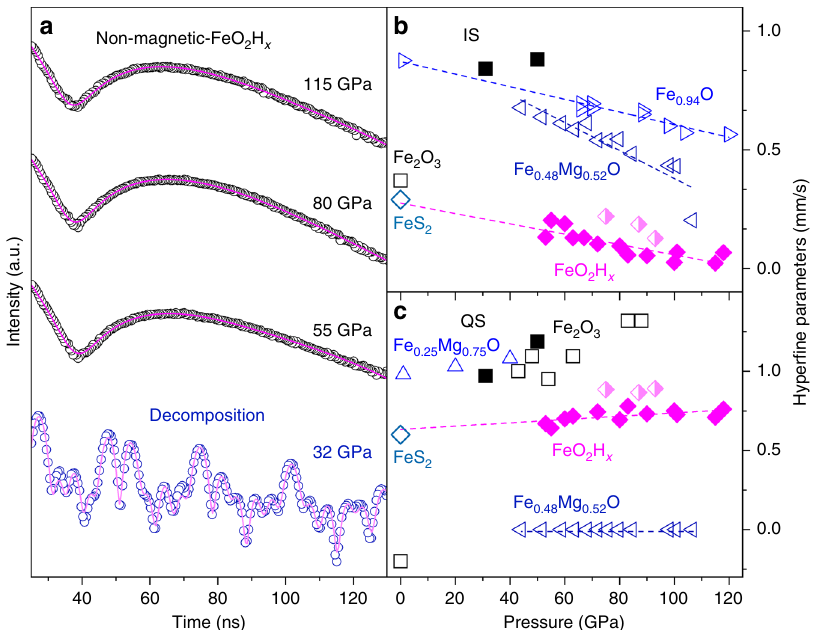
Fig. 2 Representative SMS spectra and hyper fi ne parameters. a High pressure Mössbauer spectra of FeO 2 H x collected upon decompression at 300 K. Circles: experimental SMS spectra; red solid lines: modeled spectra using CONUSS program. Comparison of isomer shift ( b ) and quadrupole splitting ( c ) of iron in iron-rich compounds at high pressure and room temperature. Solid and half- fi lled diamonds: pyrite-structured FeO 2 H x and FeO 2 , respectively, this study; open diamonds: pyrite FeS 2 (ref. 29 ); solid squares: Fe 2 O 3 , this study; open squares: Fe 2 O 3 (ref. 58 ); left-, right-, and top-pointing triangles: (Fe 0.48 Mg 0.52 )O (ref. 27 ), Fe 0.94 O (ref. 26 ), and (Fe 0.25 Mg 0.75 )O (ref. 28 ), respectively; dashed lines: linear fi ts to experimental data. The errors on the experimental data are ±2 SD, which are smaller than symbols and not shown for clarity